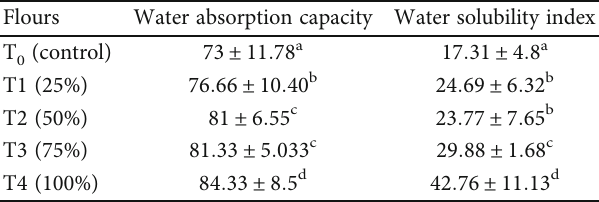
Mean values in the same column with di ff erent superscript letters are signi fi cantly di ff erent ( P < 0 : 05 ). T 0 ð control Þ = 100 % wheat fl our; T1 = 25 % sweet potato and soybean fl ours; T2 = 50 % sweet potato and soybean fl ours; T3 = 75 % sweet potato and soybean fl ours; T4 = 100 % sweet potato and soybean fl